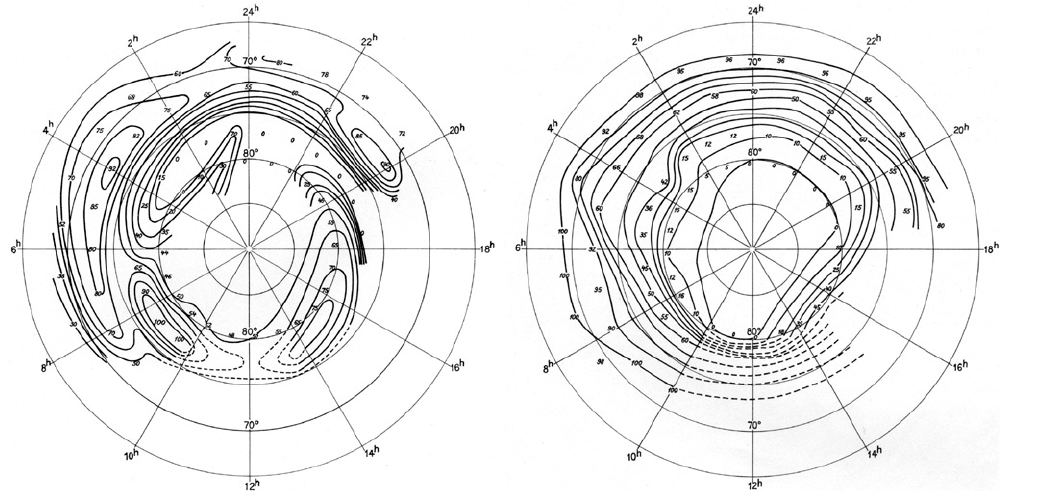
Figure 25. Iso-auroral contours for sunspot minimum (left) and maximum (right). Note that local noon is downward (Lassen, 1963).